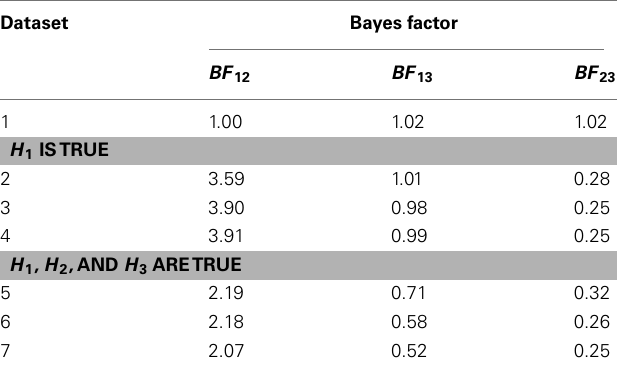
Table 3 | Bayes factors for the comparison of the informative hypotheses with one